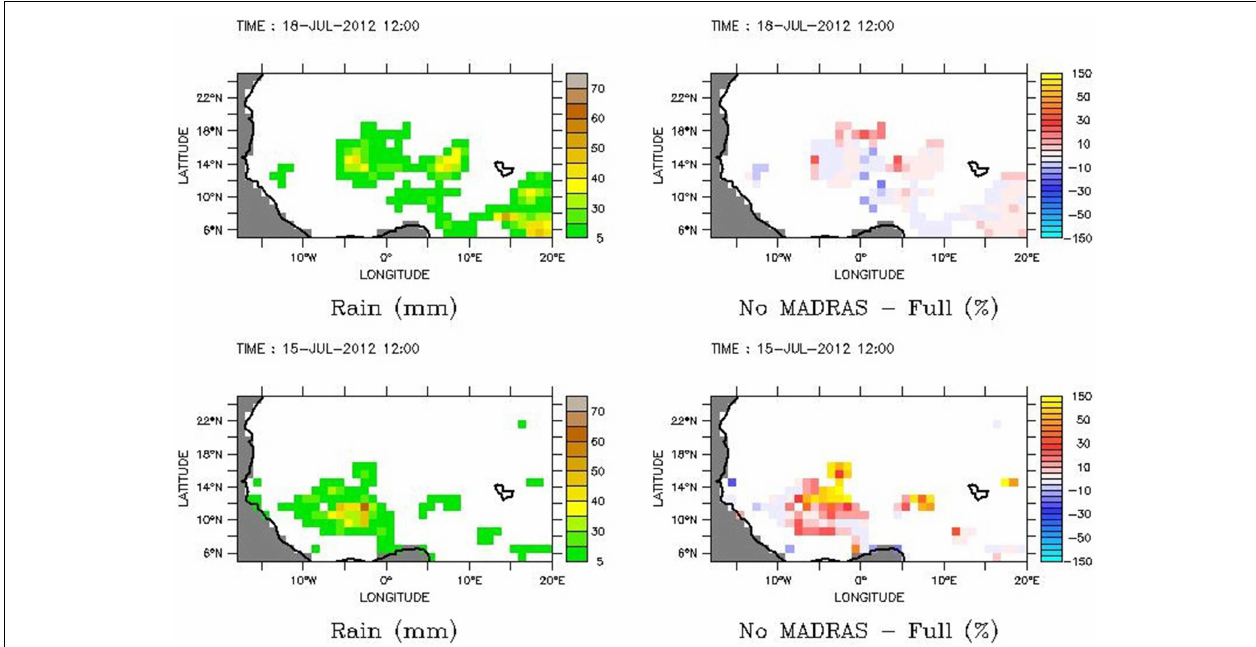
FIGURE 12 | TAPEER daily rainfall for July 18 (top) and July 15, 2012 (bottom). The daily rainfall (left) and the relative difference without MADRAS-with MADRAS computation